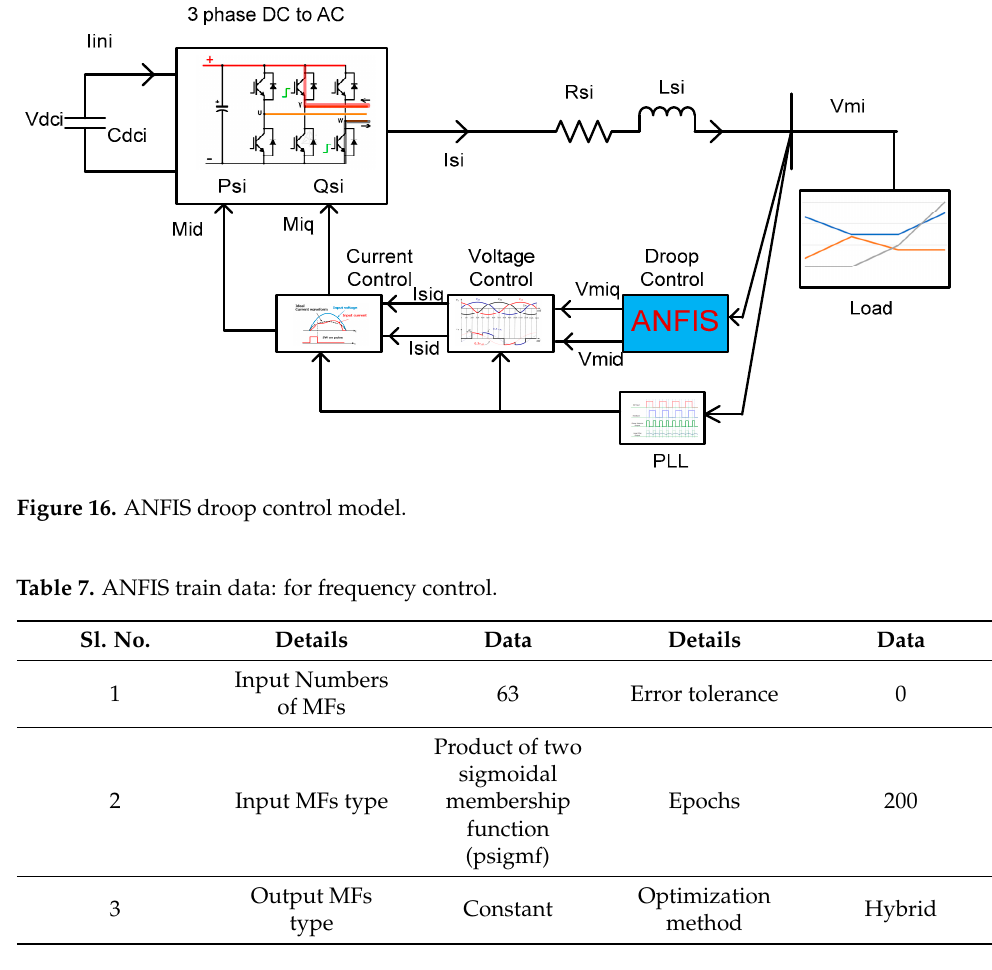
Table 8. ANFIS train data: for Voltage